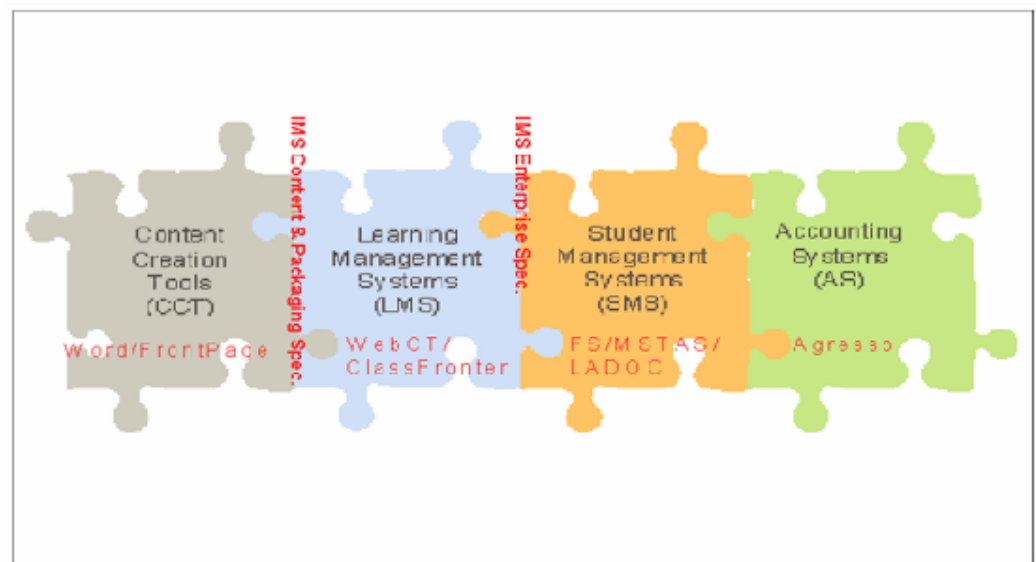
Figure 1. The Chain of Online Education